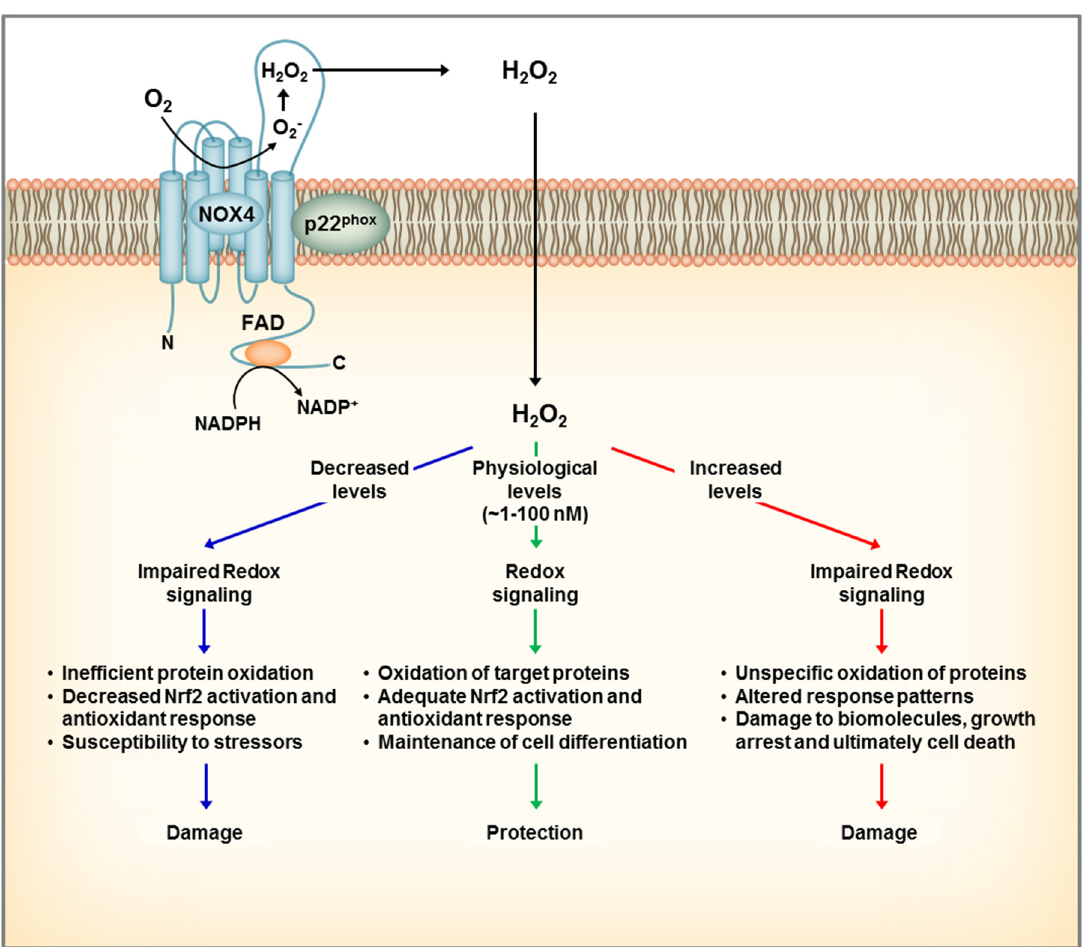
Figure 3. Dual role of NOX4 in the kidney. NOX4 localizes to the plasma and intracellular membranes and generates constitutively H 2 O 2 that participates in redox signaling. At physiological conditions, NOX4 mediates a steady redox signal, which favors cellular quiescence and differentiation and overall exerting a protective role. The case of complete loss of NOX4 leads to inefficient oxidation of protein targets, which makes the cell more susceptible to challenges by stressors, and ultimately leads to cell damage. On the other hand, overexpression of NOX4 leading to increases in H 2 O 2 levels, can result in oxidative damage to proteins and ultimately cell death.